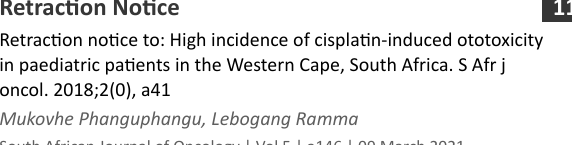
Retraction Notice Retraction notice to: High incidence of cisplatin-induced ototoxicity in paediatric patients in the Western Cape, South Africa. S Afr j oncol. 2018;2(0),